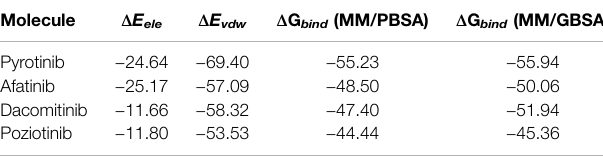
TABLE 3 | Binding energy of HER2 -targeted TKIs towards HER2 ex20ins variant G776delinsVC. Molecule Δ E ele